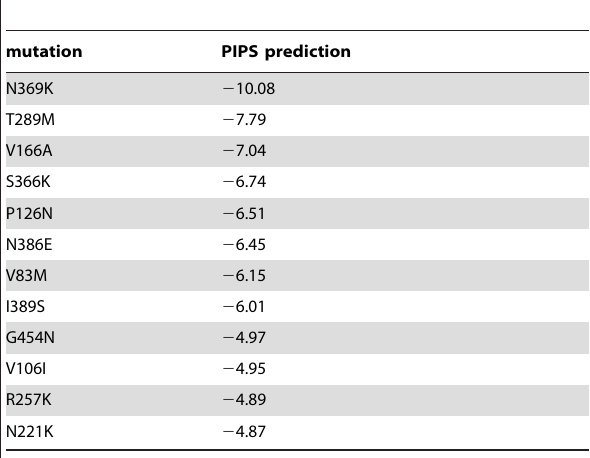
Top predicted mutations to A/California/4/2009 neuraminidase, excluding mutations not in crystallized ectodomain and only considering the top prediction at each site. Mutations named in N1 numbering scheme.